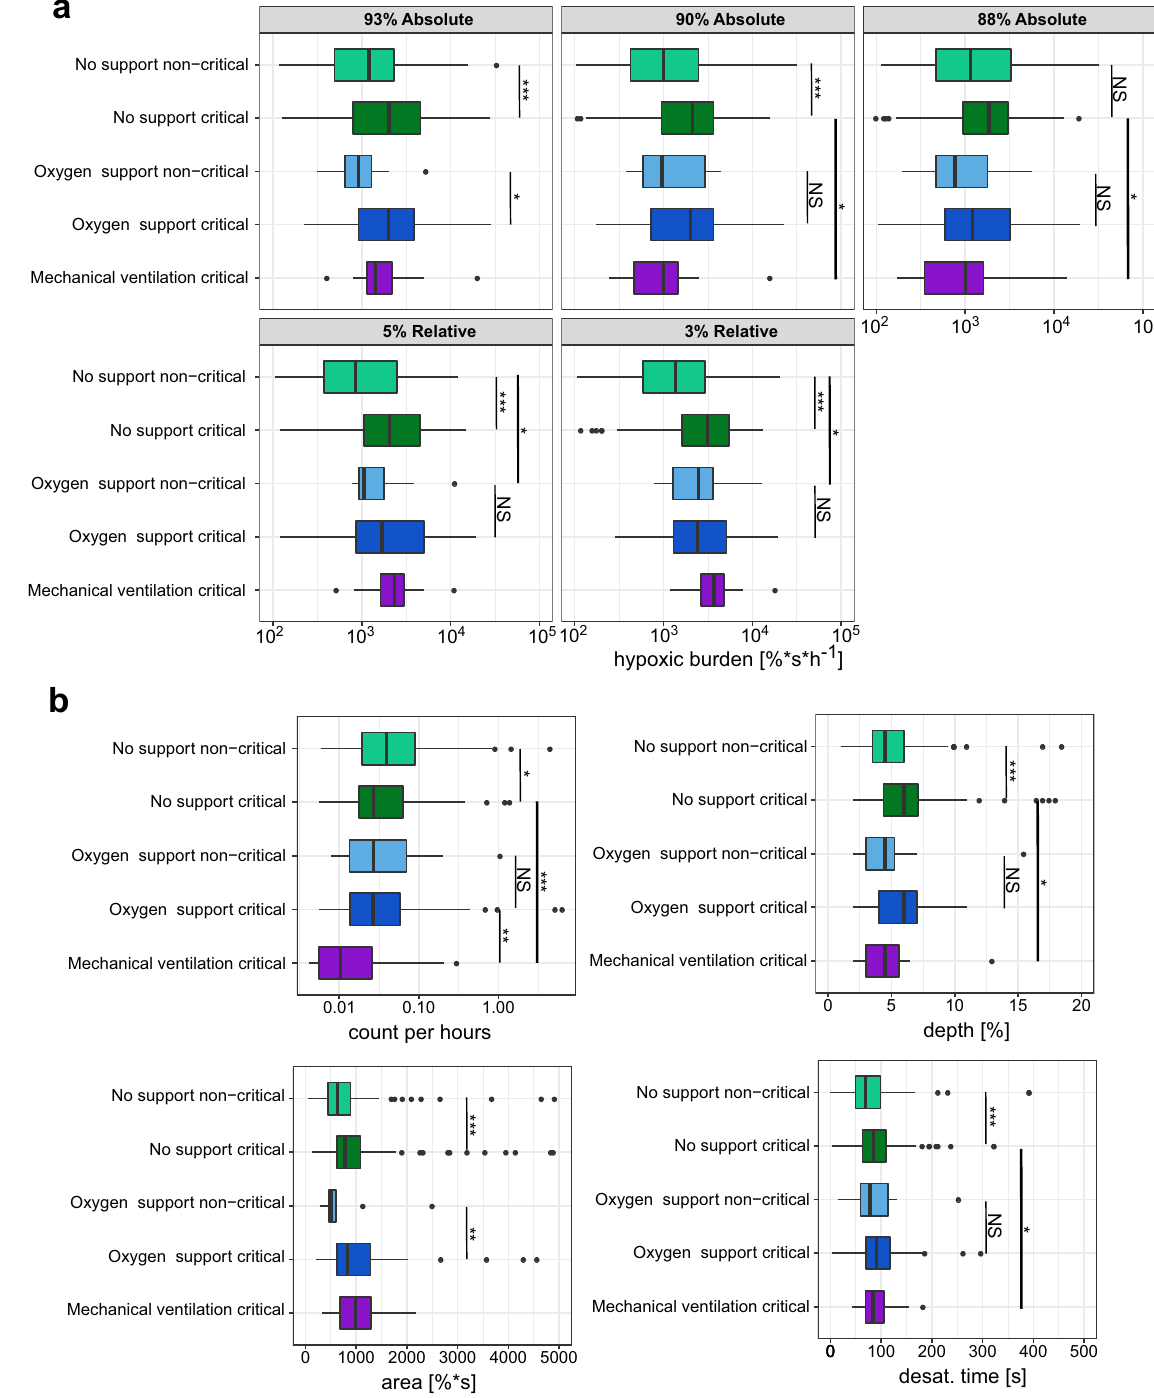
Figure 4. Desaturation definition and parameters. ( a ) Hypoxic burden for each relative or absolute desaturation definition (see supplementary information and Figure S2). The hypoxic burden was defined as the sum of desaturation areas normalised by recording duration. The hypoxic burden was based on relative or absolute threshold and was measured under oxygen support, mechanical ventilation or without support in critical and non-critical patients. ( b ) Desaturation characteristics for critical and non-critical patients with or without oxygen or mechanical support. The results are shown for an absolute desaturation threshold of 93%. The number of desaturations per hour, the depth the area and the desaturation time (duration between the beginning and the minimum) are represented for each group. *** Wilcoxon test p value < 0.001,** p value < 0.01,* p value < 0.05, NS non-significant. The center of boxplot indicates the median, and the low and high edges indicate the 25th and 75th percentiles, points indicate